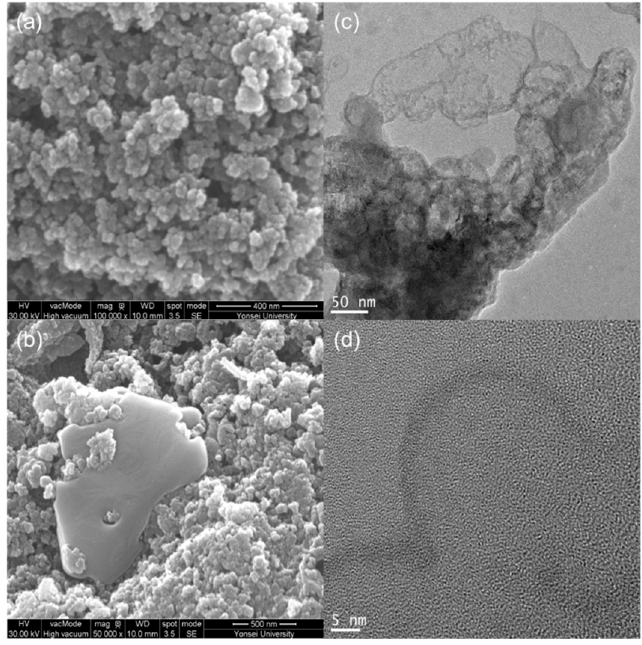
Figure 5. Morphology and pore texture of CPSN. SEM images ( a , b ) and TEM images ( c , d ).